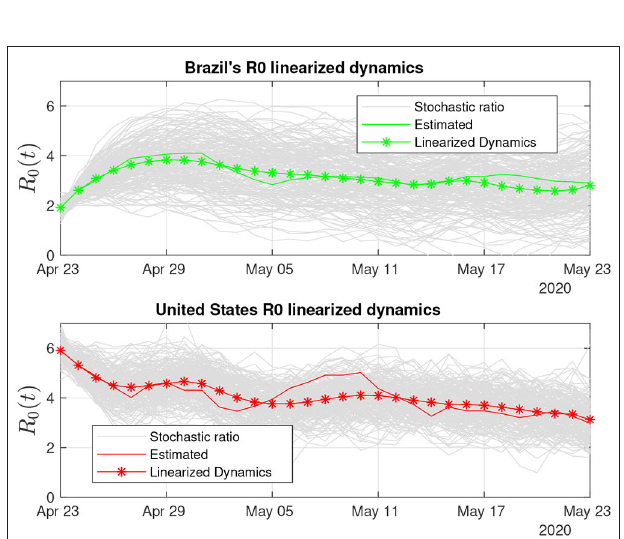
FIGURE 7 | Comparison of normalized relative estimation error costs between the proposed RLS-based technique and the least mean squares (LMS) estimation algorithm. The average processing time of RLS and LMS algorithms was, respectively, 14 and 20 ms.